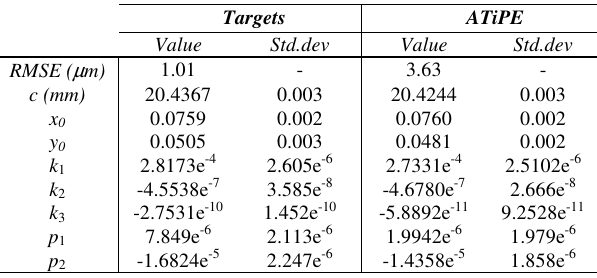
Table 2. Results for a Nikon D200 equipped with a 20 mm Nikkor lens, with and without